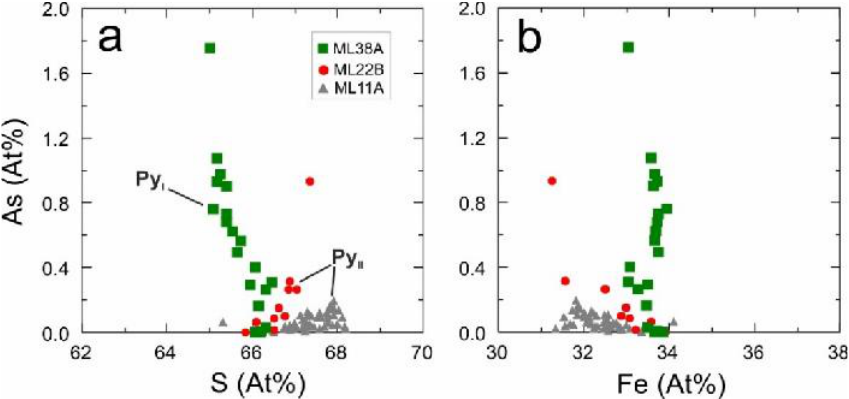
Figure 9. Chemical variations of colloform pyrite I (ML38A) and massive pyrite II (ML22B, ML11A) as a function of ( a ) As‐S and ( b ) As‐Fe.